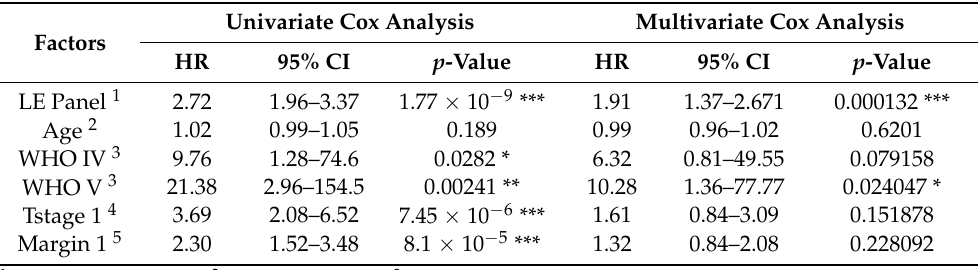
Table 2. Univariate and multivariate Cox analysis of LE gene panel for PC relapse.